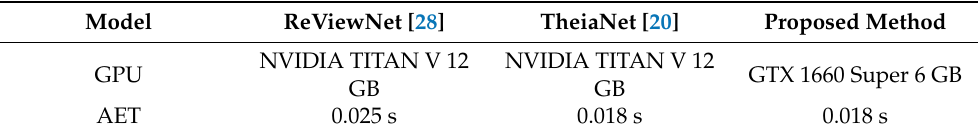
Table 9. Comparison of average execution time per frame on